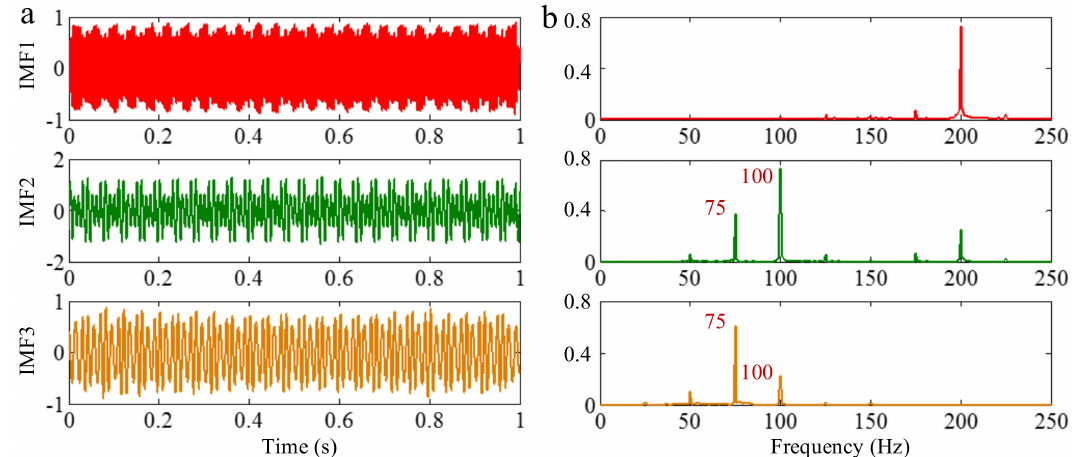
Figure 14. The waveforms of the IMFs 1–3 of f sig 1 and the corresponding Fourier spectrums: ( a ) waveforms and ( b ) Fourier spectrums.